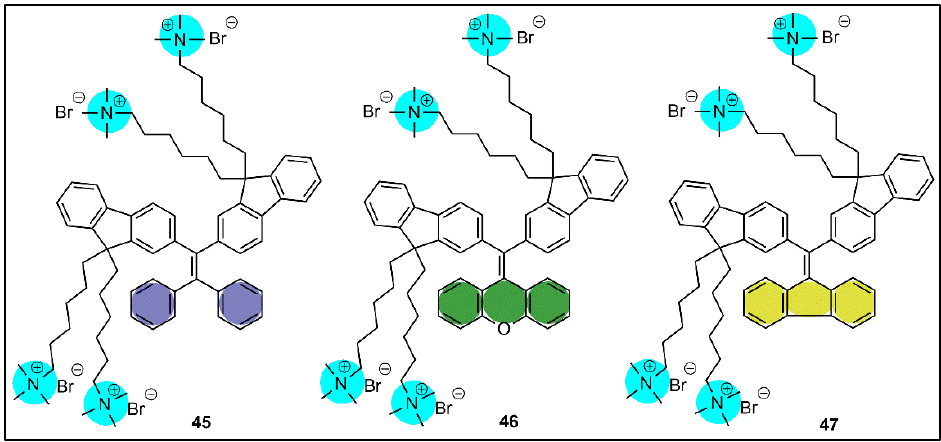
Figure 45. Molecular formulas of probes 45 – 47